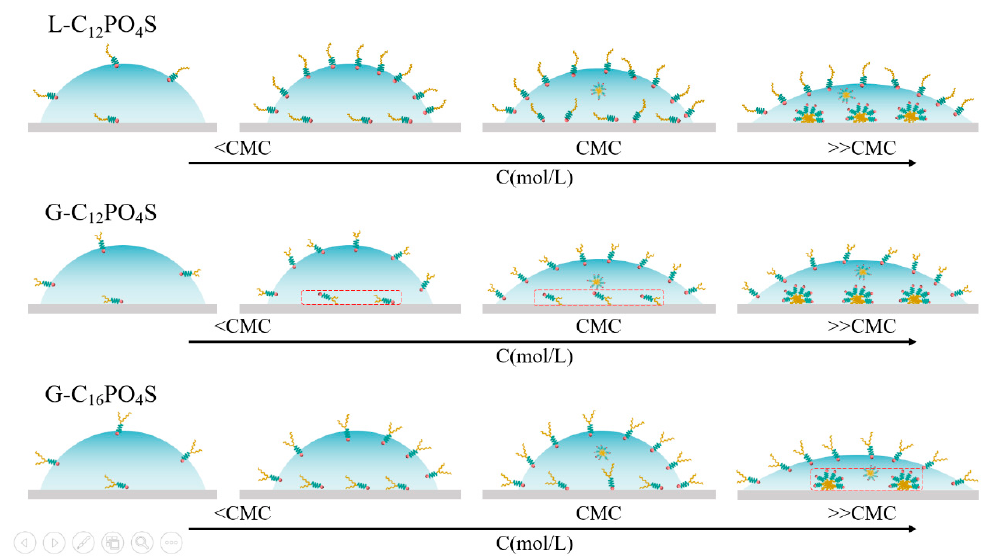
Figure 7. The possible adsorption behaviors of the surfactants on the PMMA surface.